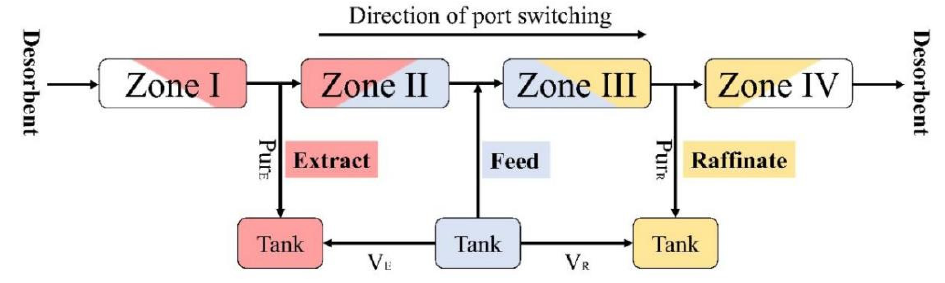
Figure 10. Schematic diagram of bypass SMB.